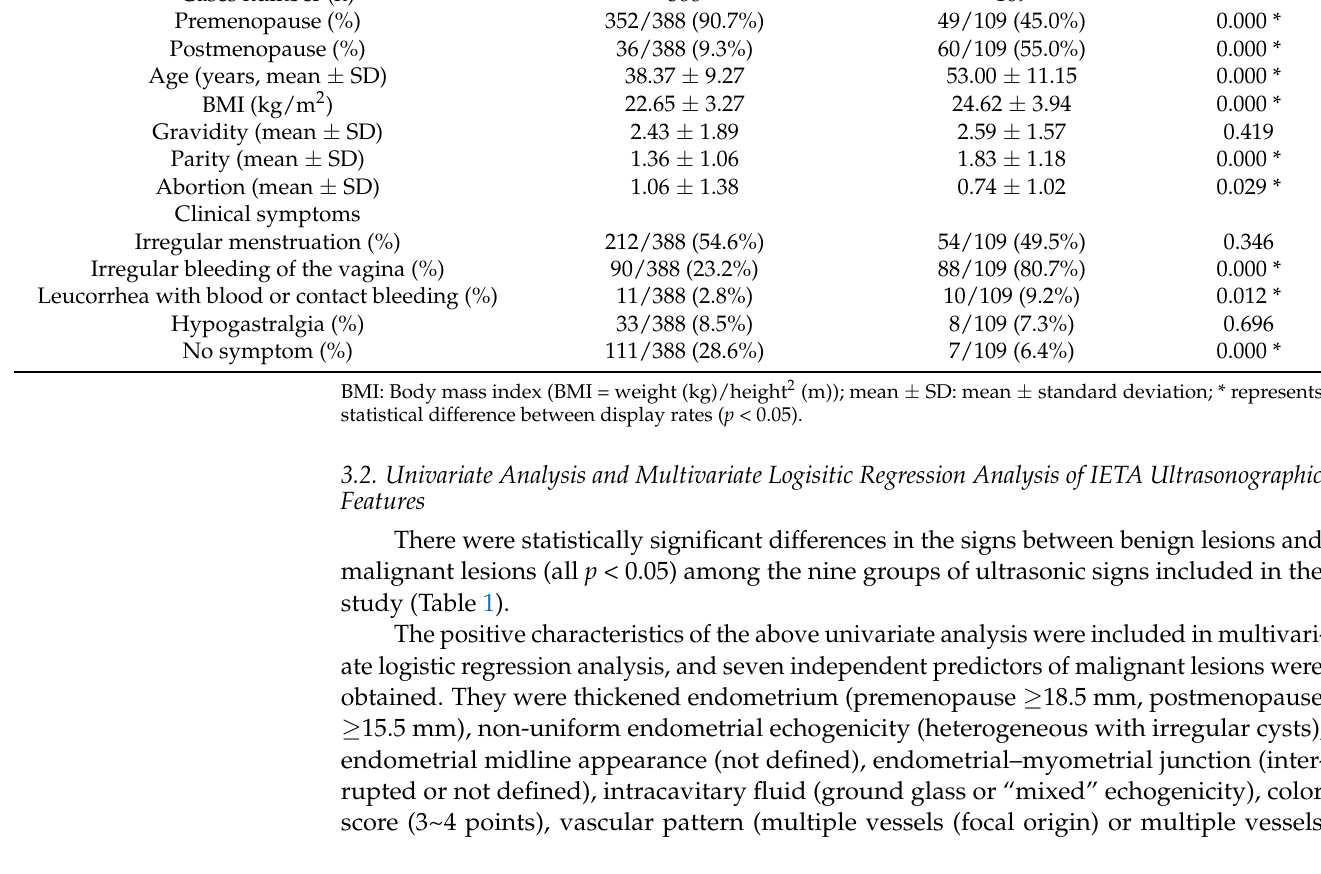
(FIGO stage IA: 57, IB: 8, II: 13, IIIA: 1, IIIC: 6, IV: 3), 9 cases of endometrial atypical hyper- plasia, 1 case of endometrial low-grade squamous intraepithelial lesion, 3 cases of uterine carcinosarcoma (FIGO stage IB: 1, IIIB: 1, IVA: 1), 1 case of giant cell type high-grade undif-